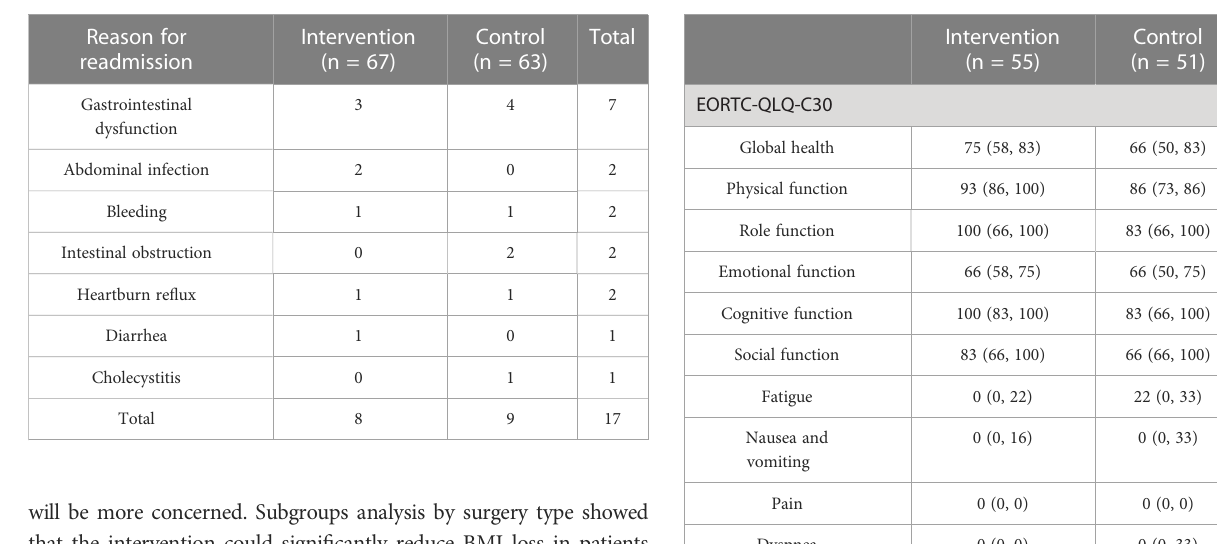
TABLE 5 Reasons for readmission within 90 days after surgery. TABLE 6 Evaluation of patient QOL at 90 days after